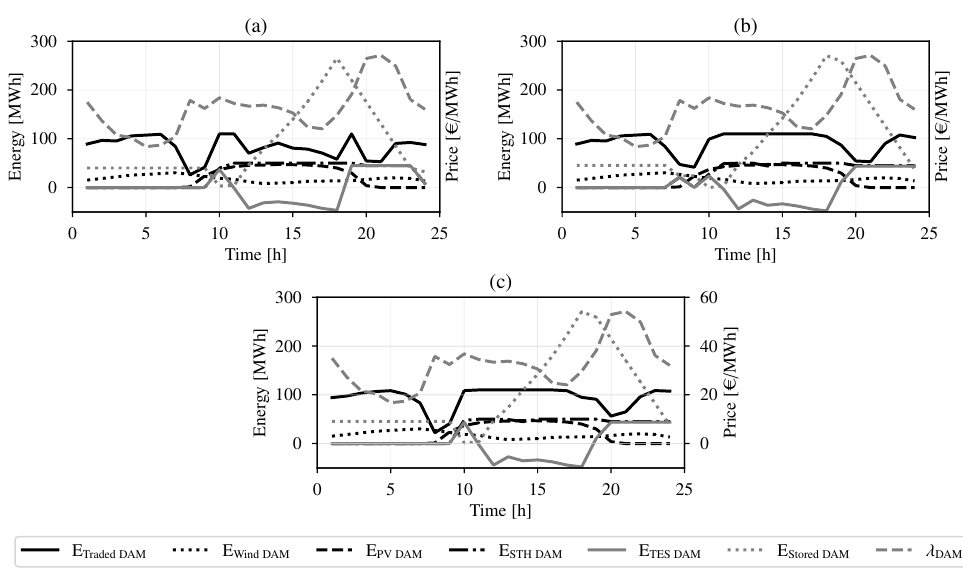
Figure 9. Output of assets at DAM on a clear day: ( a ) No Coordination; ( b ) VPP with default load profile; ( c ) VPP with three load profiles at zero